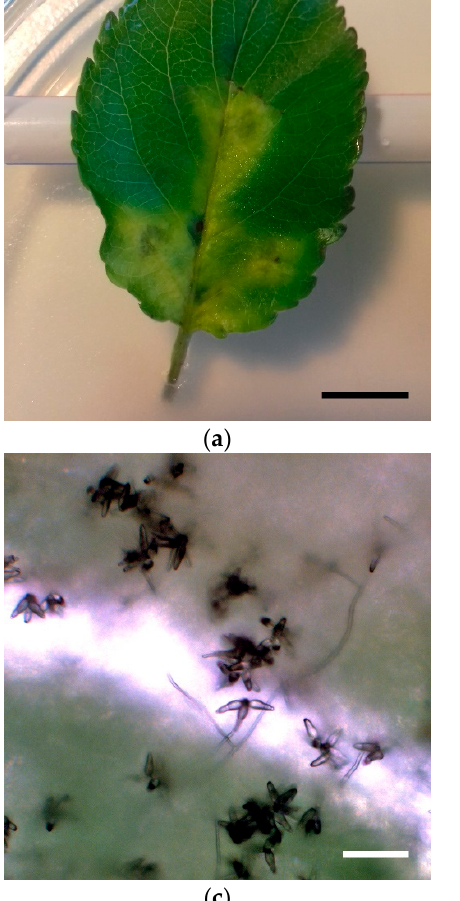
Figure 2. Symptoms caused by V. inaequalis on the detached leaves of ‘Gala’, 14 days post-inoculation: ( a ) Sporulating lesions surrounded by chlorosis, scale = 5 mm; ( b ) Conidia alongside running hyphae, forming a characteristic net-like or “crisscross” shape, scale = 0.5 mm; ( c ) conidia developing on conidiophores in clusters, scale = 50 μ m.